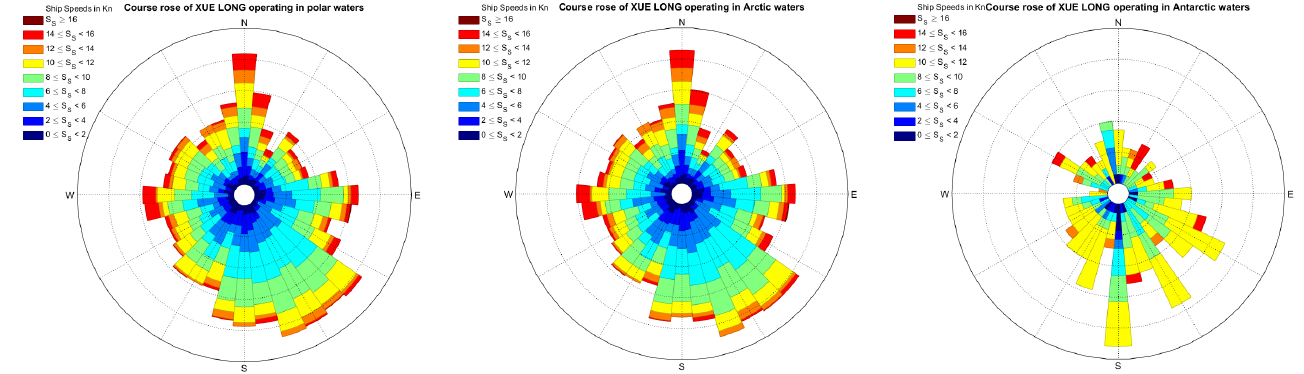
Figure 5. Rose chart of the ship’s course distribution in polar waters.